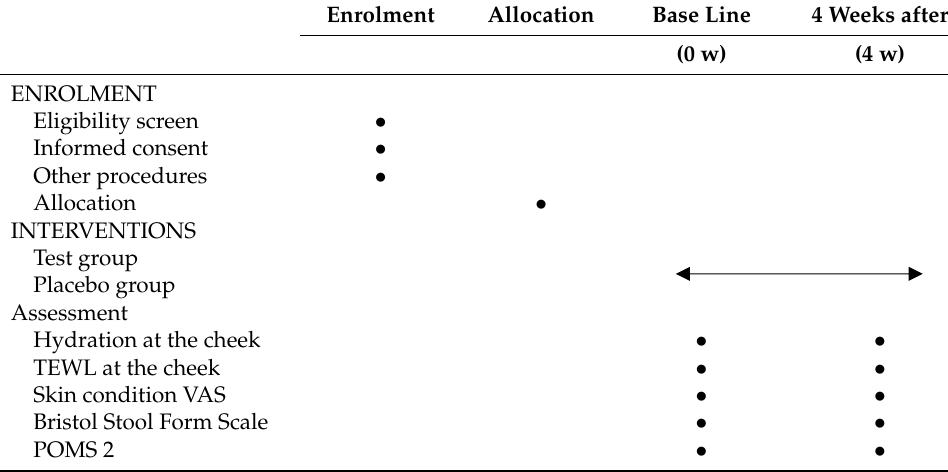
Table 3. The schedules of enrolment, intervention, and assessment. Enrolment Allocation Enrolment